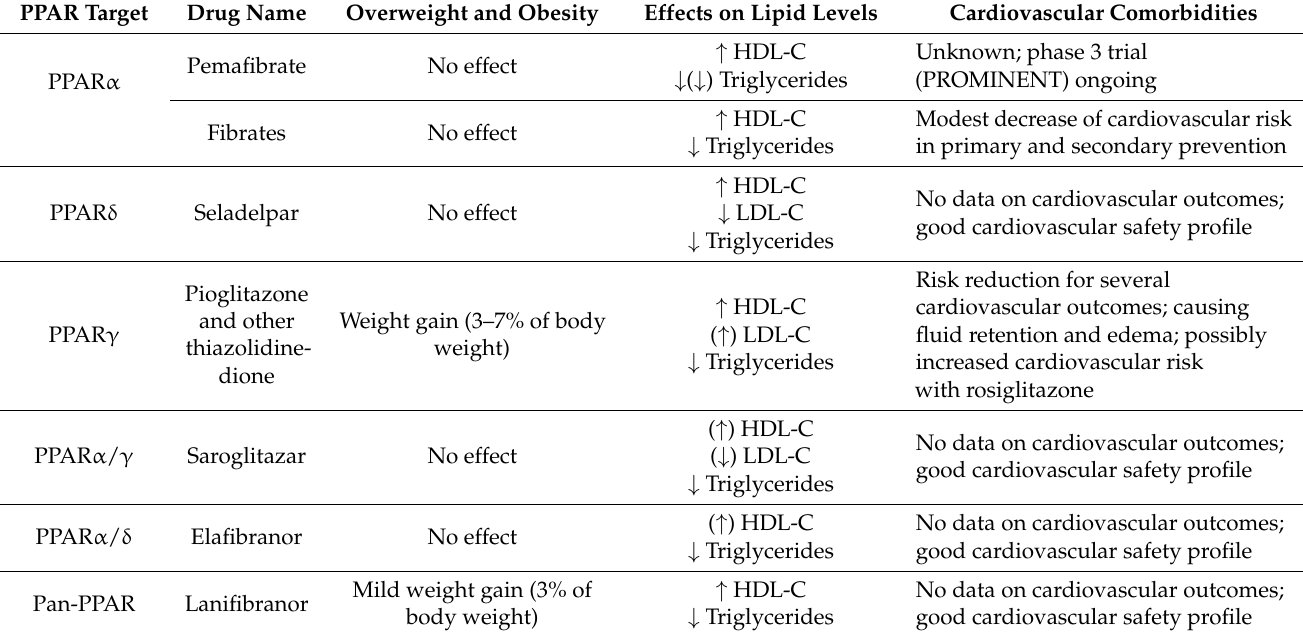
Table 3. Effects of PPAR-directed therapy on other comorbidities of the metabolic